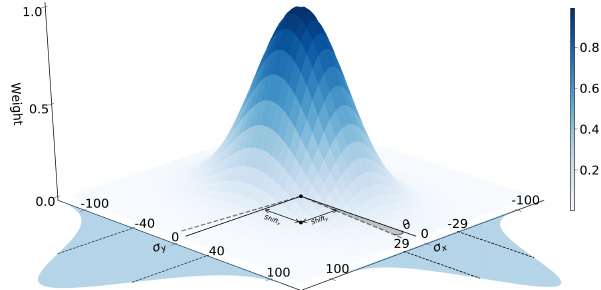
Figure E1. A typical MODIS ePSF on the spatial resolution of S2, i.e. a unit of 1 represents 10m on the X – Y plane, and it follows the same notations as in Eqs. (E2)–(E4). The shaded areas on the two sides represent the Gaussian functions used for x and y directions, with 1 σ shown with vertical dashed